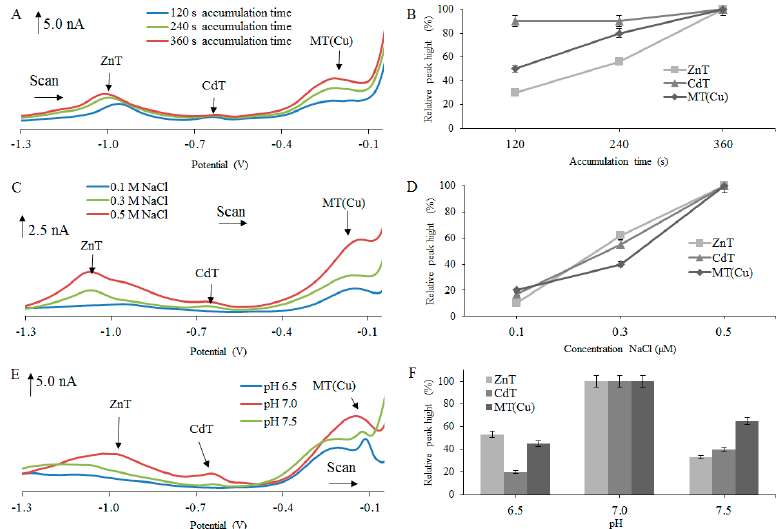
Figure 2. DP voltammograms of 2 µM human MT3 protein (hMT3) from brain measured in different ( A ) accumulation times, ( C ) concentration of NaCl, and ( E ) pH. AdTS DPV parameters were as follows: initial potential − 1.5 V, end potential 0.0 V, modulation time 0.057 s, time interval 0.2 s, step potential of 1.05 mV/s, modulation amplitude of 25 mV. Dependences of heights of ZnT, CdT, and MT(Cu) signals on ( B ) accumulation times of 120, 240, 360 s; ( D ) concentration of electrolyte (0.1, 0.3, 0.5 M); and ( F ) pH (6.5, 7.0, 7.5), expressed in relative percentage peaks and peak height (nA).